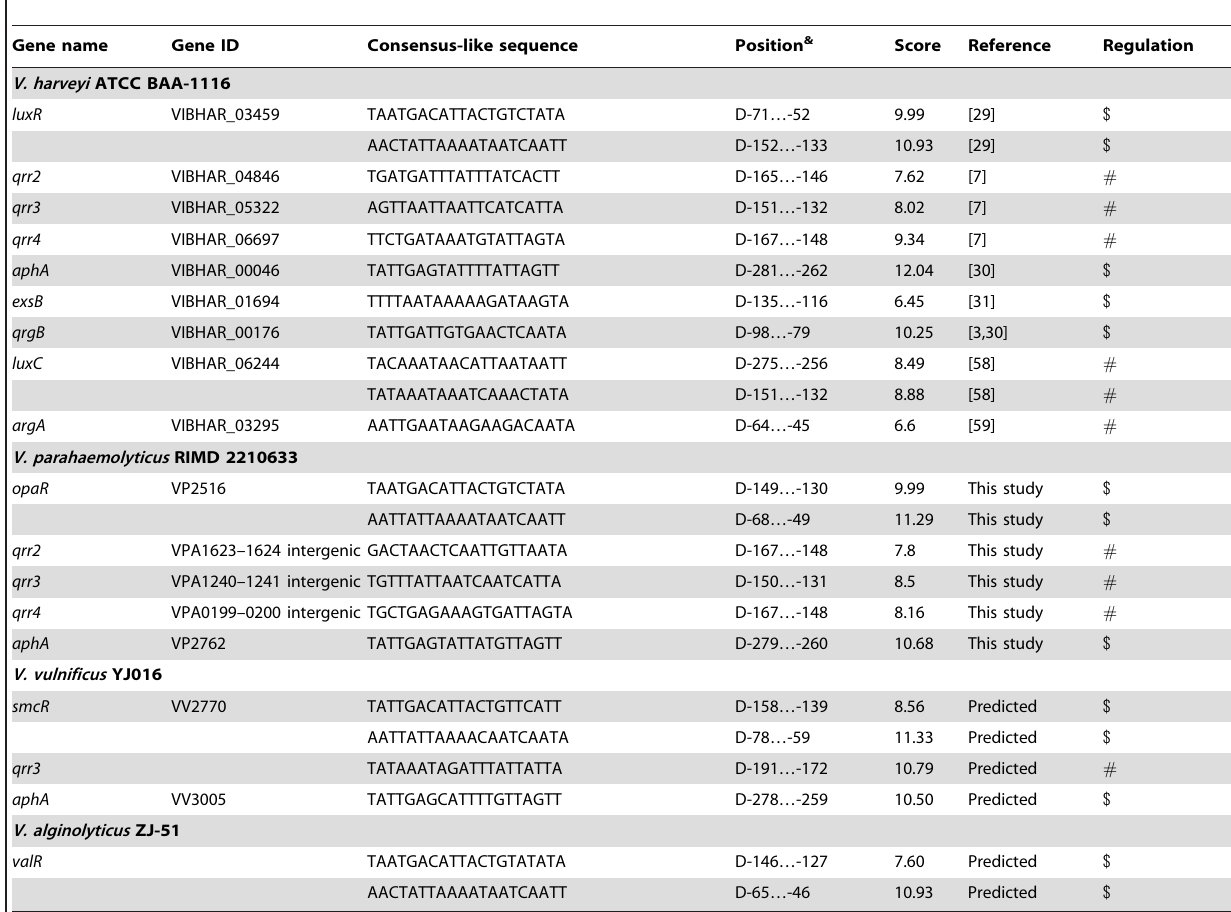
Table 2. Known or predicted direct targets of OpaR or its